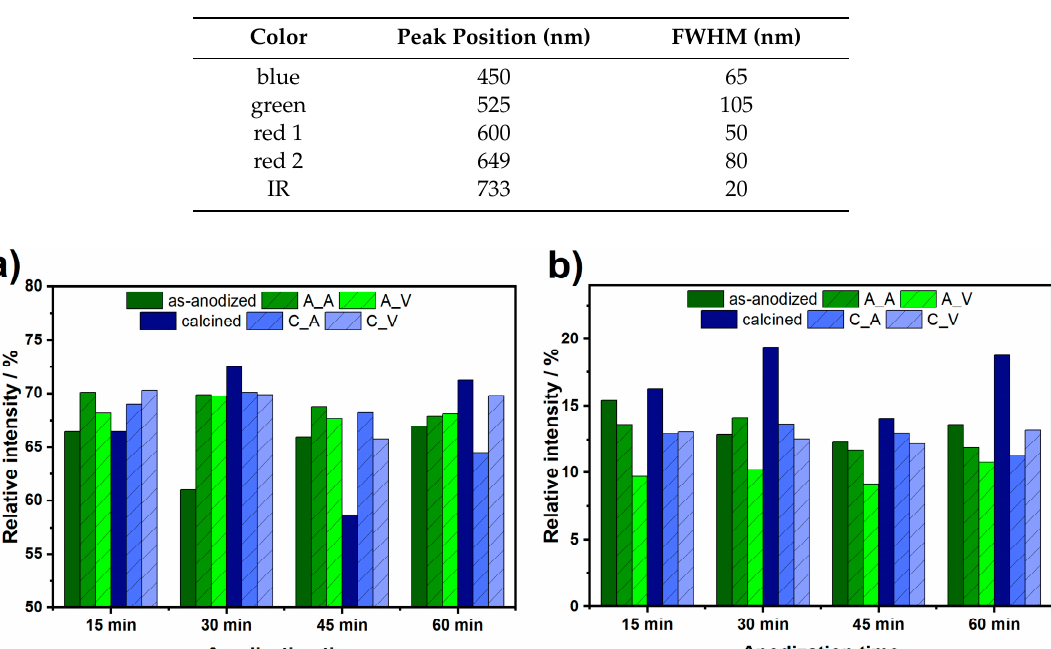
Figure 7. The emission spectrum of as-anodized TiO 2 nanotubes obtained for the 45-min synthesis. Table 3. The fitting parameters used to perform deconvolution of photoluminescence spectrum of TiO 2 -45.